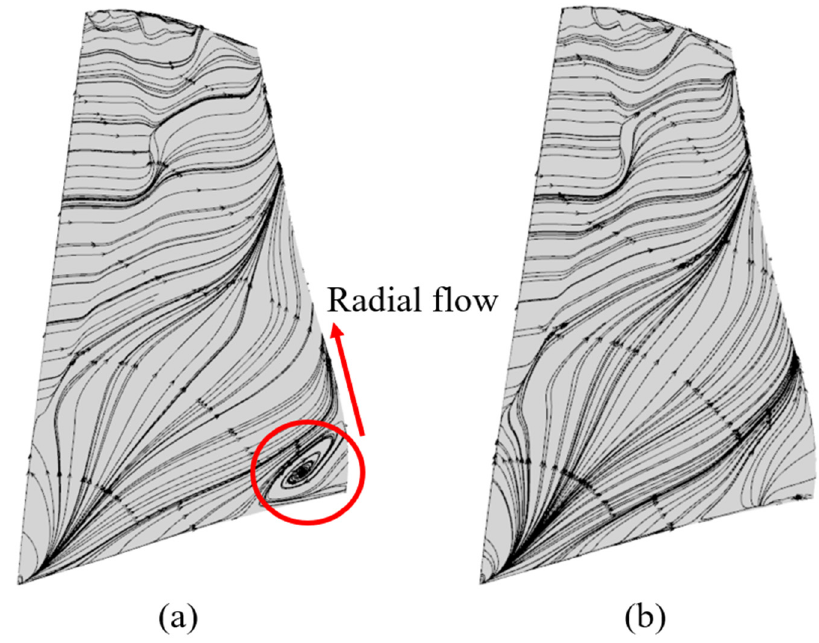
Figure 9. Limiting streamline of two schemes. ( a ) SES; ( b ) CCT.